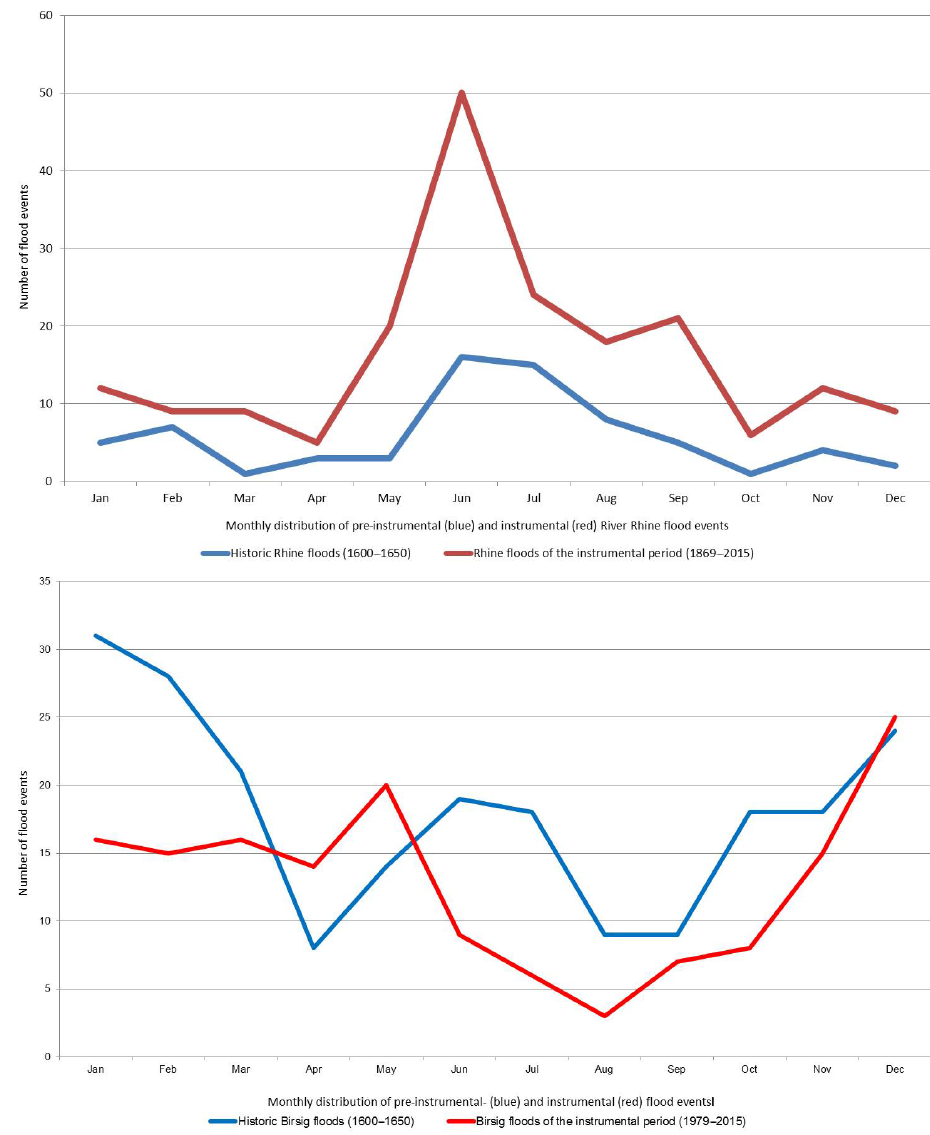
Figure 18. Distribution of historical and instrumental Rhine and Birsig flood events in